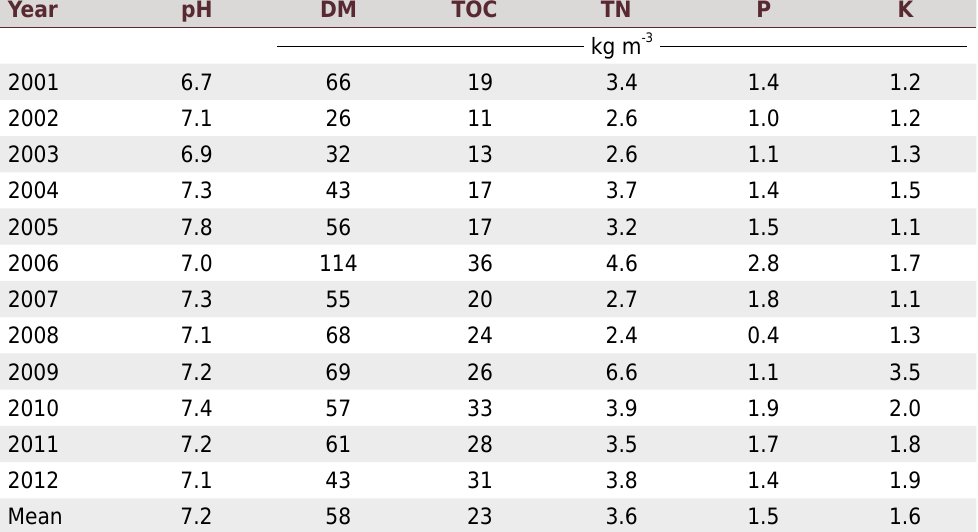
Table 1. Chemical properties of the pig slurry applied yearly in field experiment within the period from 2001-2012 on a Typic Hapludox